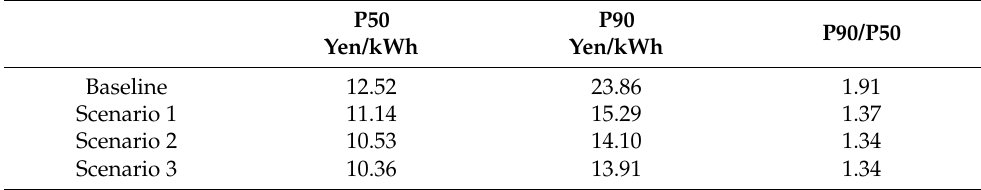
Figure 12. Comparison of predicted probability density distribution for each scenario. Table 9. Predicted P50 and P90 for each scenario.